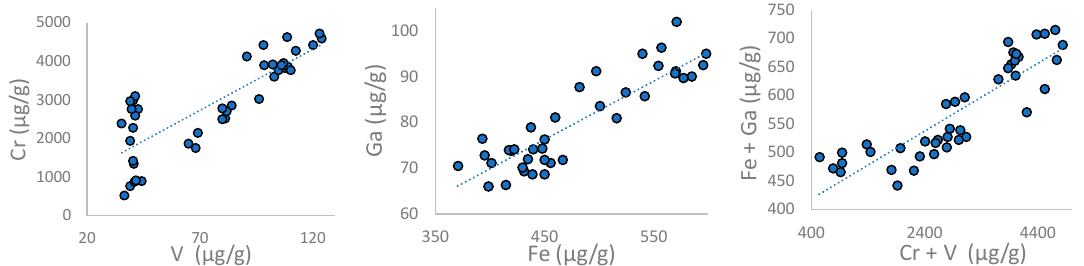
Figure 7. Trace element distribution within ruby grains oriented perpendicular to the c -axis on Cr vs. V (left panel), Ga vs . Fe (middle panel) and Fe+Ga vs . Cr + V (right panel) binary plots.